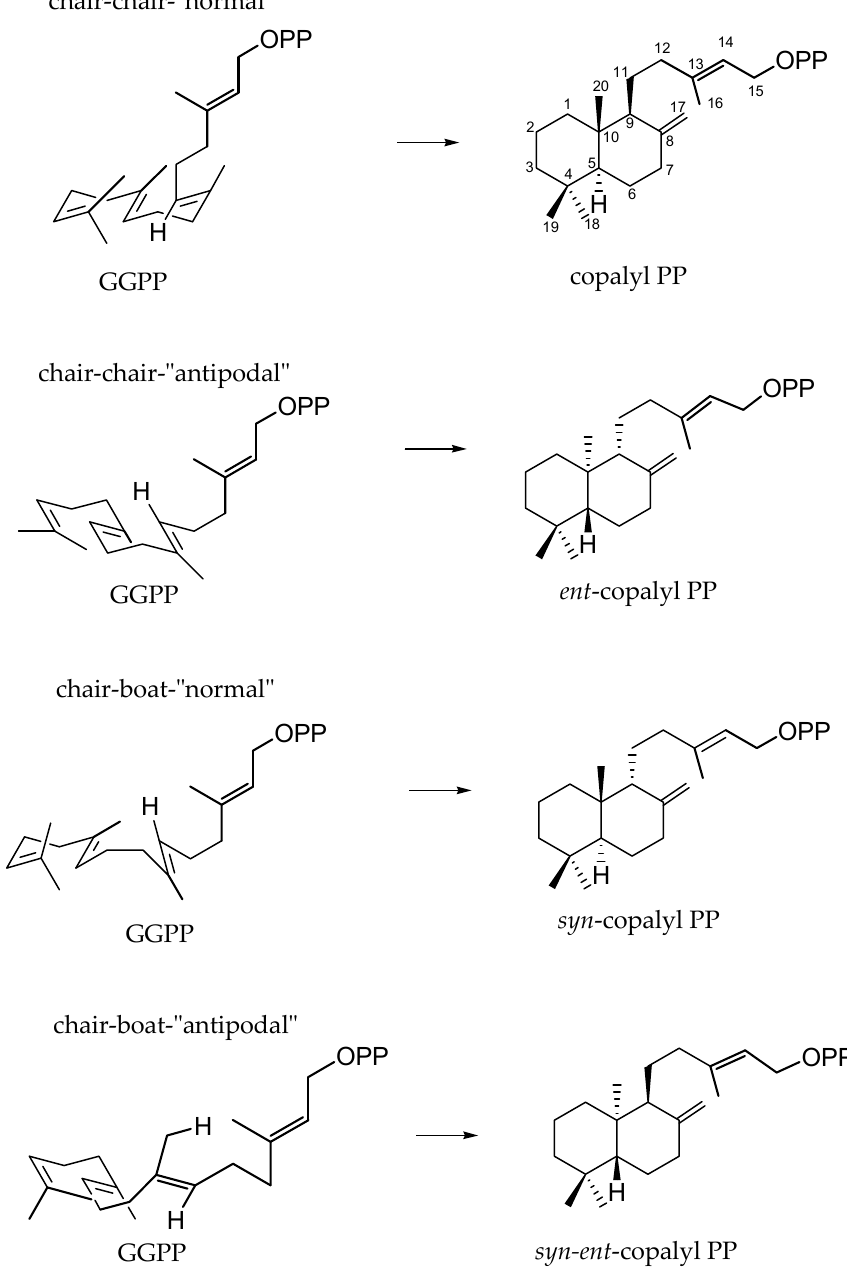
Figure 1. Conformational folds of geranylgeranyl diphosphate (GGPP) to copalyl diphosphate stereoisomers [10].